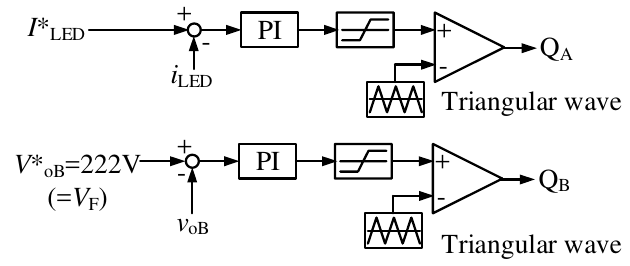
Figure 3. Control block of the proposed conventional